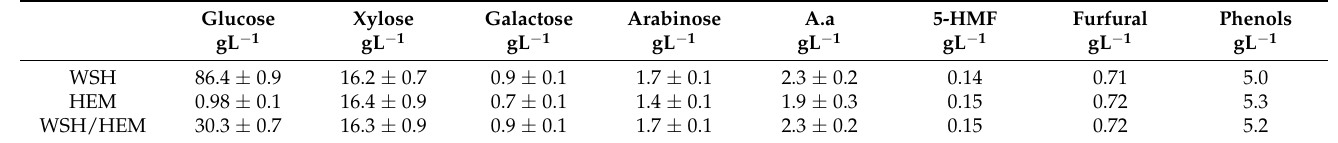
Tables WSH > Wheat straw hydrolysate, sugar medium obtained from steam explosion, and enzymatic hydrolysis of wheat straw at optimized conditions; HEM > Hemicellulose, the liquid fraction obtained from steam-pre-treated wheat straw; WSH/HEM > WSH diluted with hemicellulose in the ratio of 1:2; A.a. > Acetic